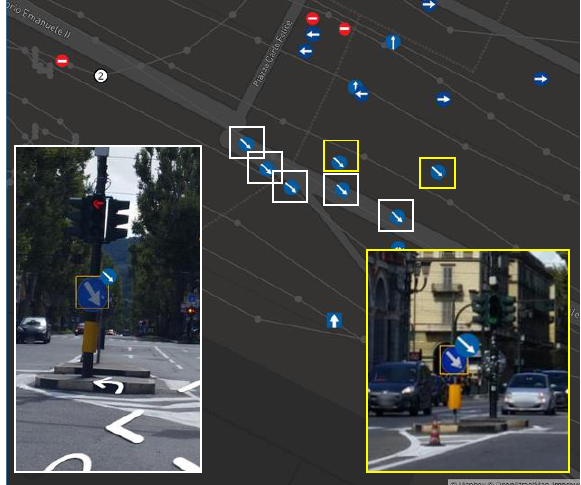
Figure 4. Multiple point features extracted by different frames/tracks related to the same “Keep right” traffic sign (snapshots from the Mapillary desktop